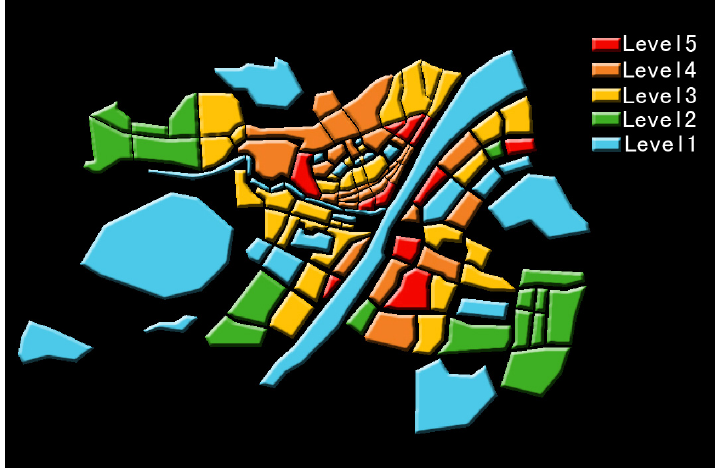
Figure 3 . City region classification Based on land surface temperature from RS.